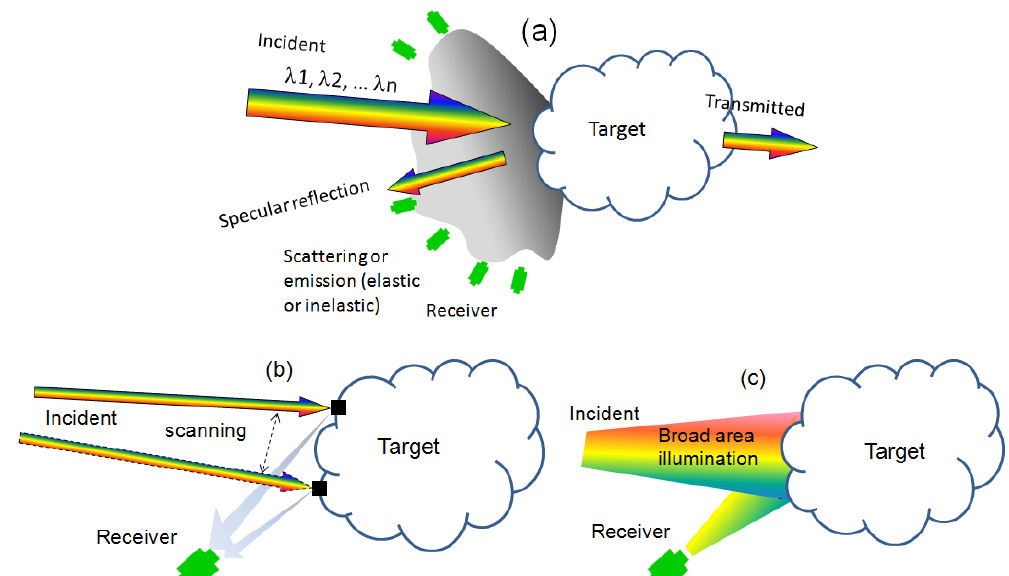
Figure 1. (a) Top: generic concept of multispectral laser imaging. (b) Lower left: imaging by scanning and point-by-point mapping; (c) Lower right: imaging with broad-area staring receiver